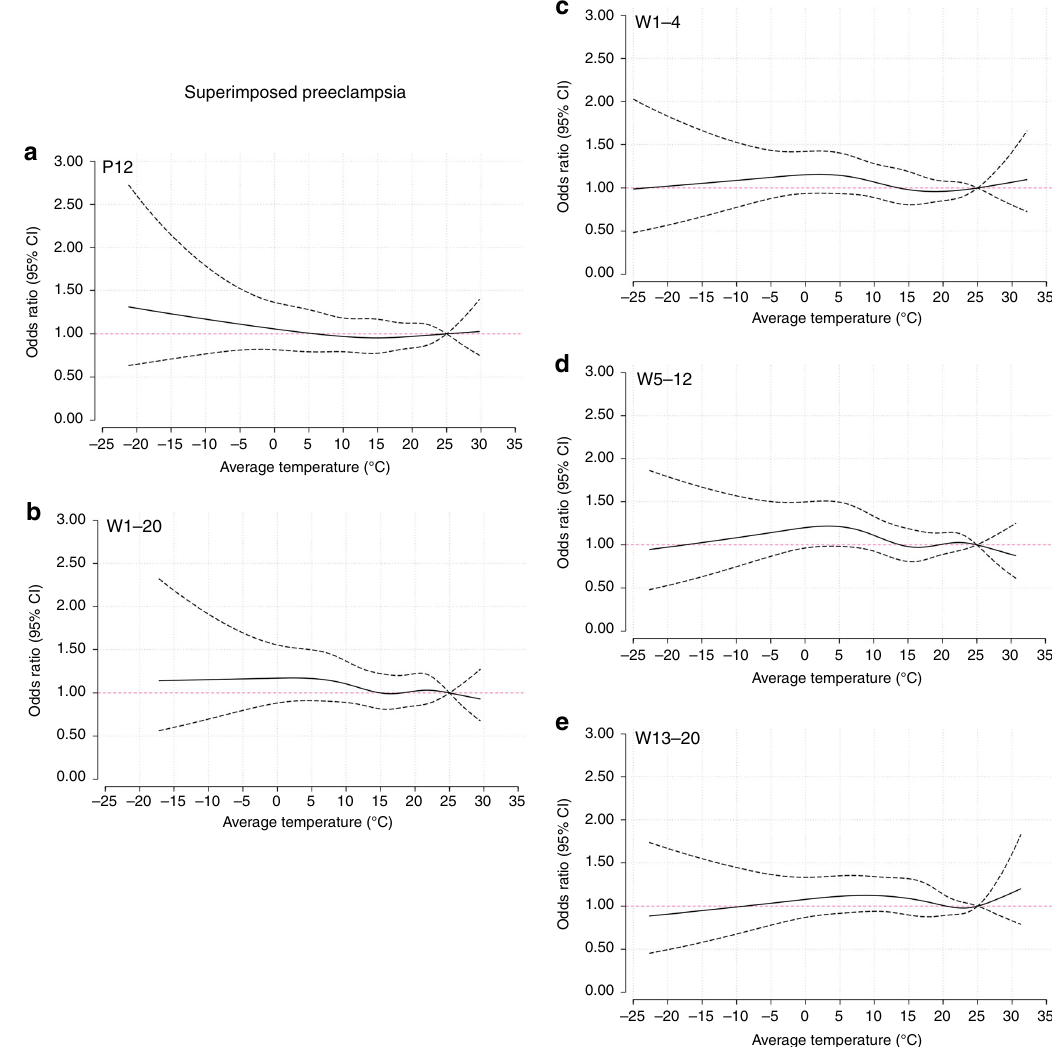
Fig. 4 Curves of the associations between average temperatures and superimposed preeclampsia. Solid black lines correspond to points estimate of aORs of superimposed preeclampsia; dashed black lines correspond to 95% con fi dence intervals. a 12 weeks preconception; b 1 – 20 weeks postconception; c 1 – 4 weeks postconception; d 5 – 12 weeks postconception; e 13 – 20 weeks postconception. PC preconception, W weeks postconception. Source data are provided as a Source Data fi